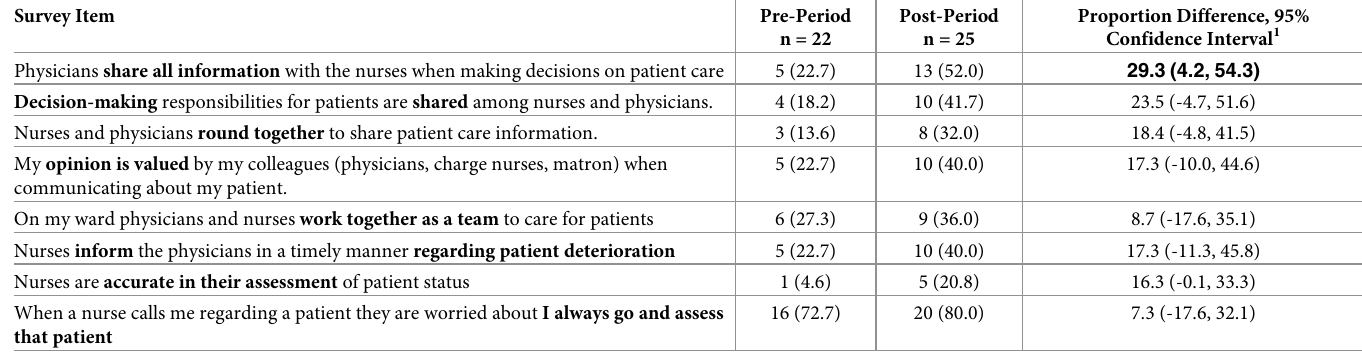
Table 1. Change in survey response,